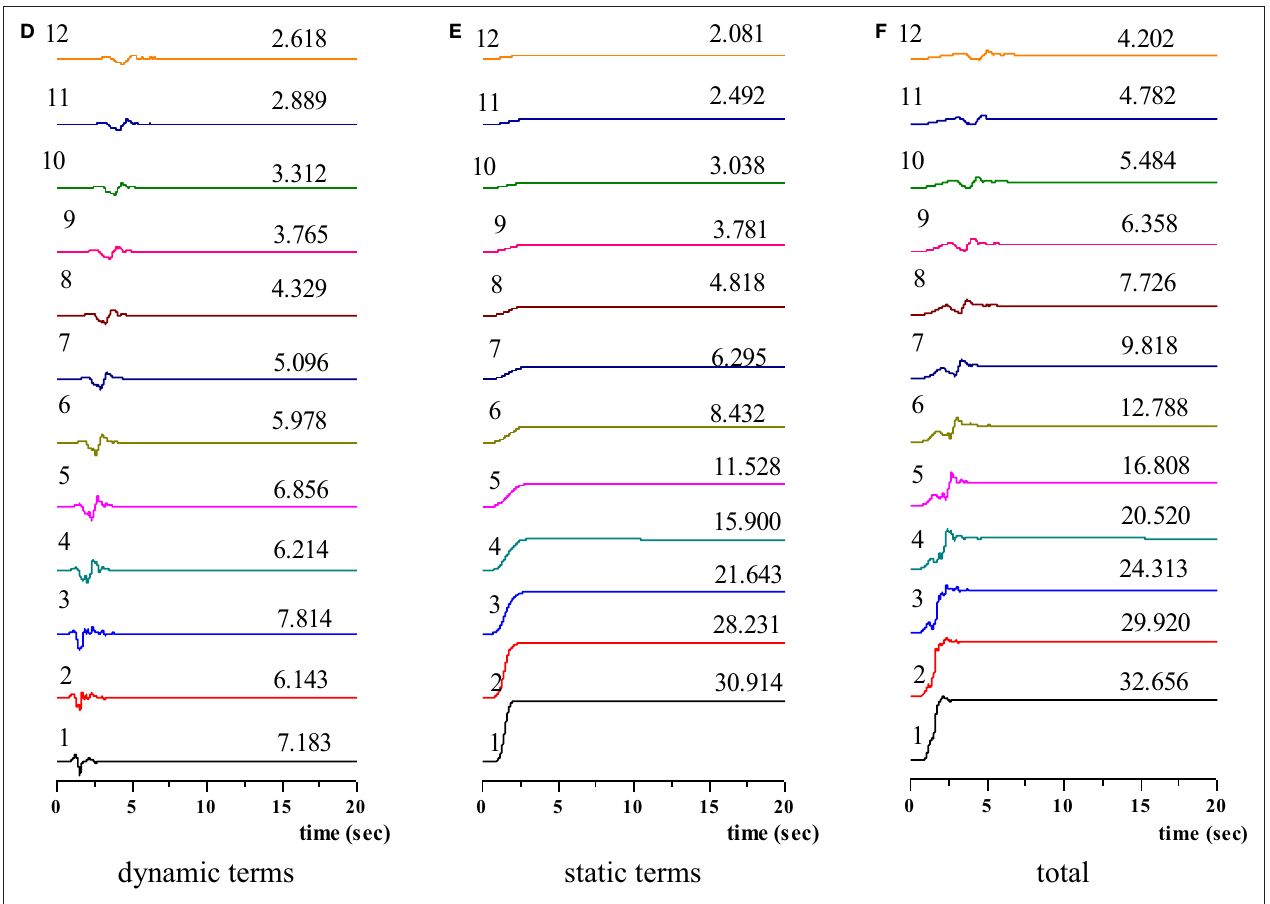
FigUre 8 | simulated time histories of velocity [(a) dynamic terms (B) static terms (c) total] and displacement [(D) dynamic terms (e) static terms (F) total] along fault-parallel (ns) direction (note: the left numbers present the observation point, right numbers present the peak values) .